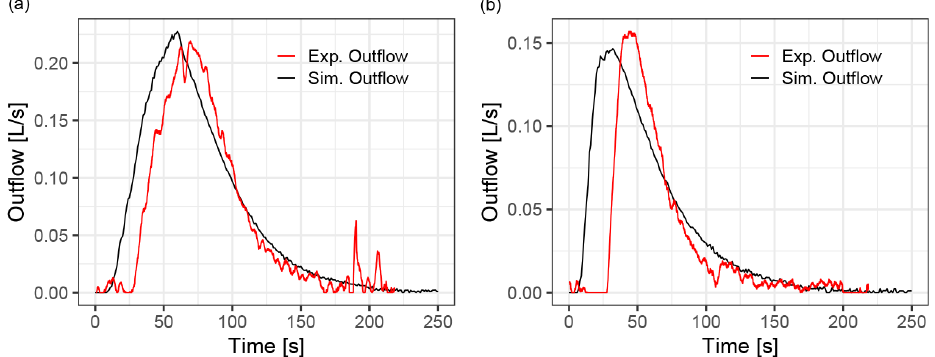
Figure A10. Simulated hydrographs compared to experimental data from Cea et al. (2010b) for two rainfall pulses on the L180 building arrangement. (a) Rainfall intensity 180mmh − 1 , duration 60s. (b) Rainfall intensity 300mmh − 1 , duration